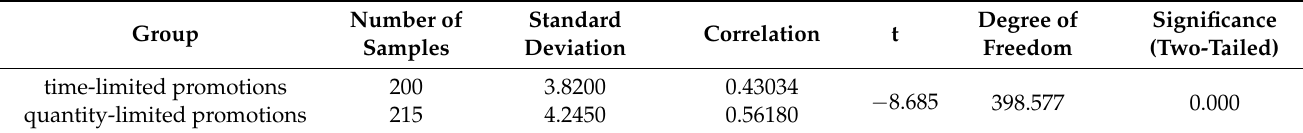
Table 8. The impact of time-limited and time-limited promotions on downward anticipated regret. Group